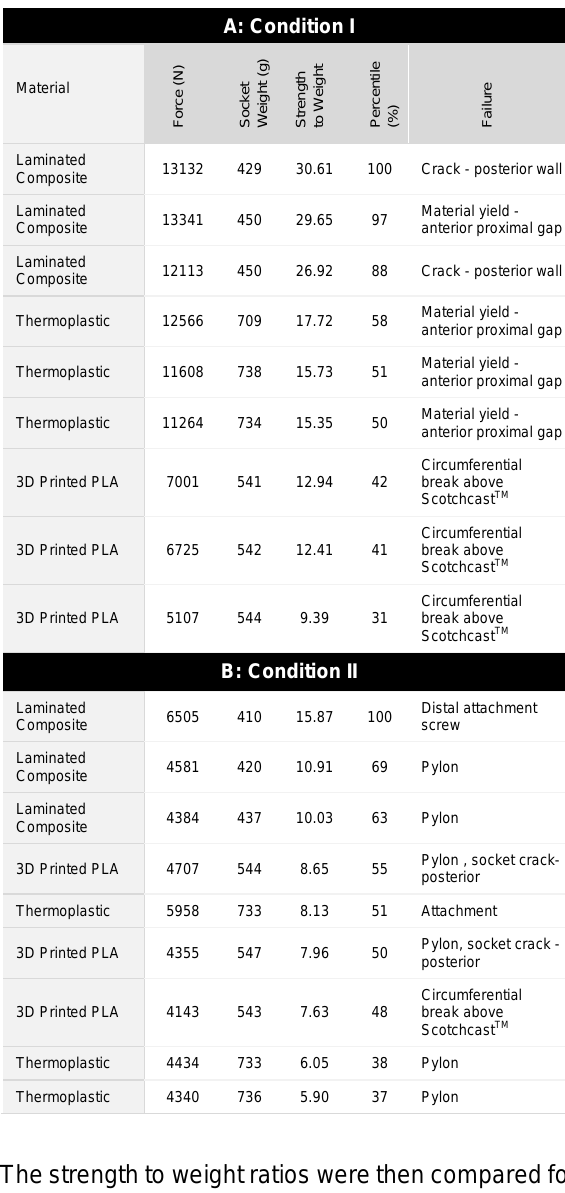
TABLE 4. A: Strength to weight ratios of cushion sockets for Condition I; B: Strength to weight ration of cushion sockets for Condition